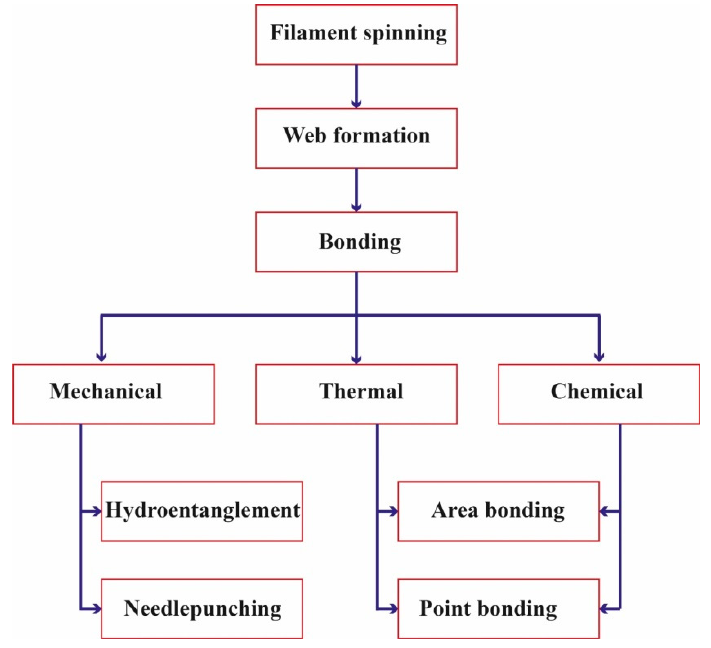
Figure 4. Sequences in spunlaid process [36].